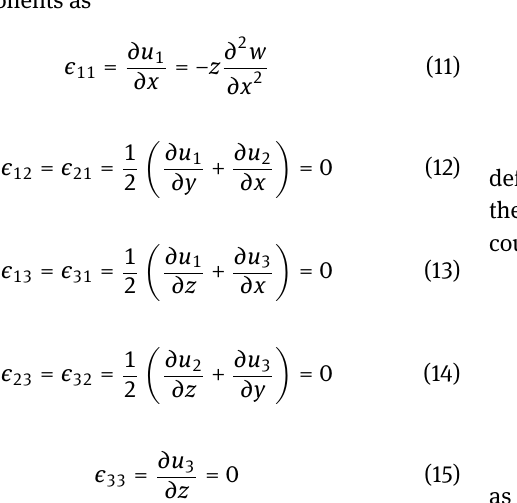
Substituting Eqs. (8)-(10) into Eq. (2) yields the macro strain components